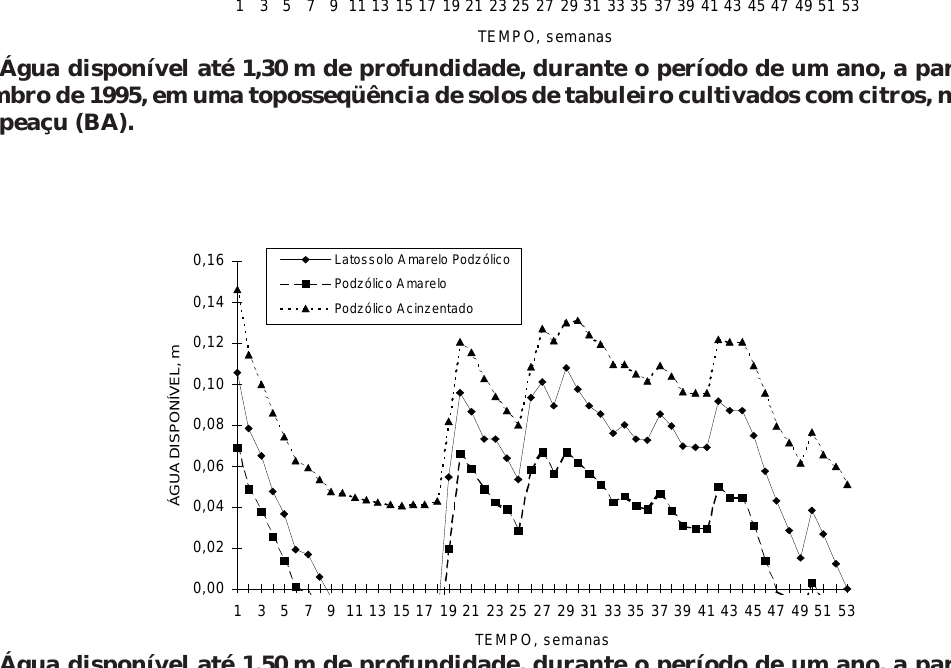
Figura 9. Água disponível até 1,50 m de profundidade, durante o período de um ano, a partir de 18 de dezembro de 1995, em uma toposseqüência de solos de tabuleiro cultivados com citros, no município de Sapeaçu